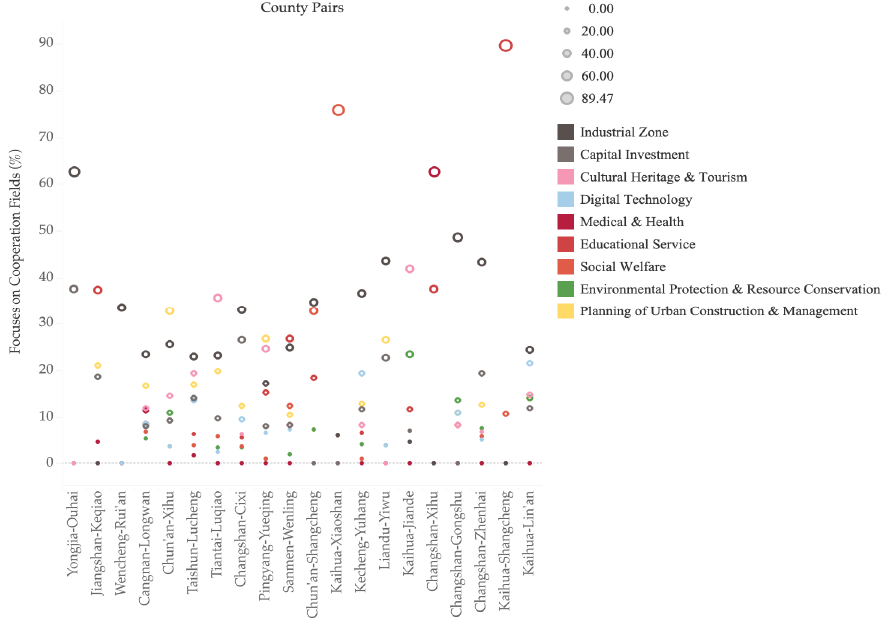
Figure 5. Proportion of cooperation fields in the top 20 county pairs.